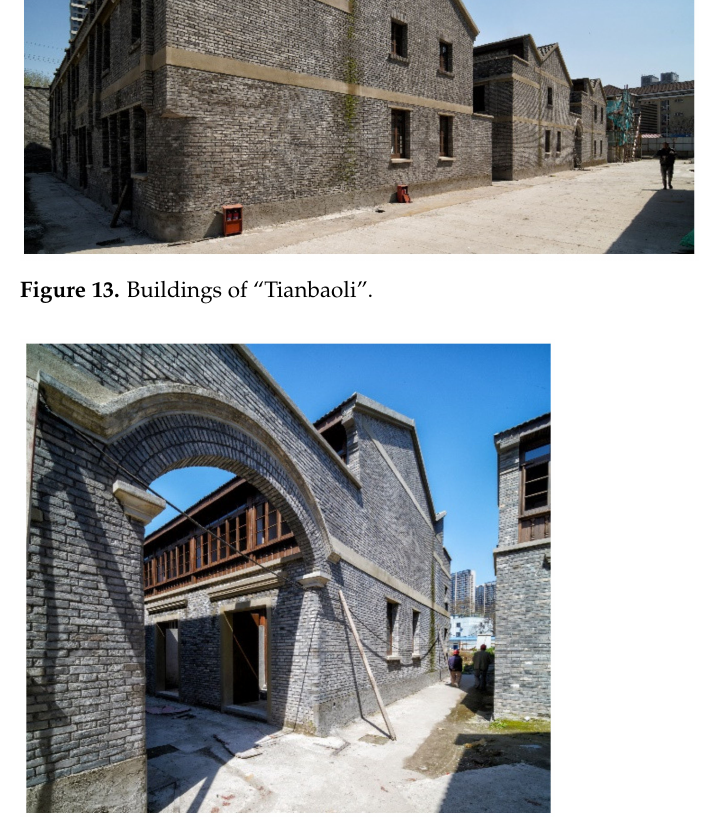
Figure 14. The No. 2 Building of